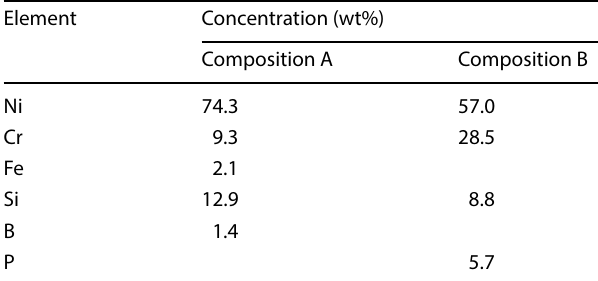
Table 2 Global compositions (wt%) of the slurries